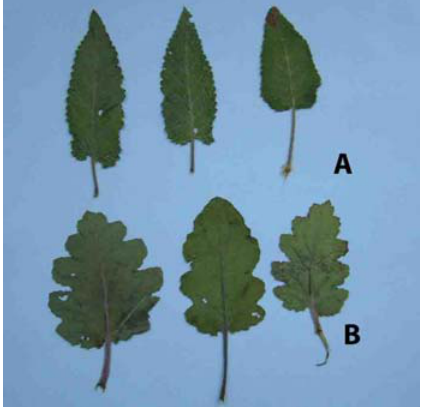
Figure 1b. Shapes of the stem leaves in S. pratensis (A) and S. bertolonii (B).